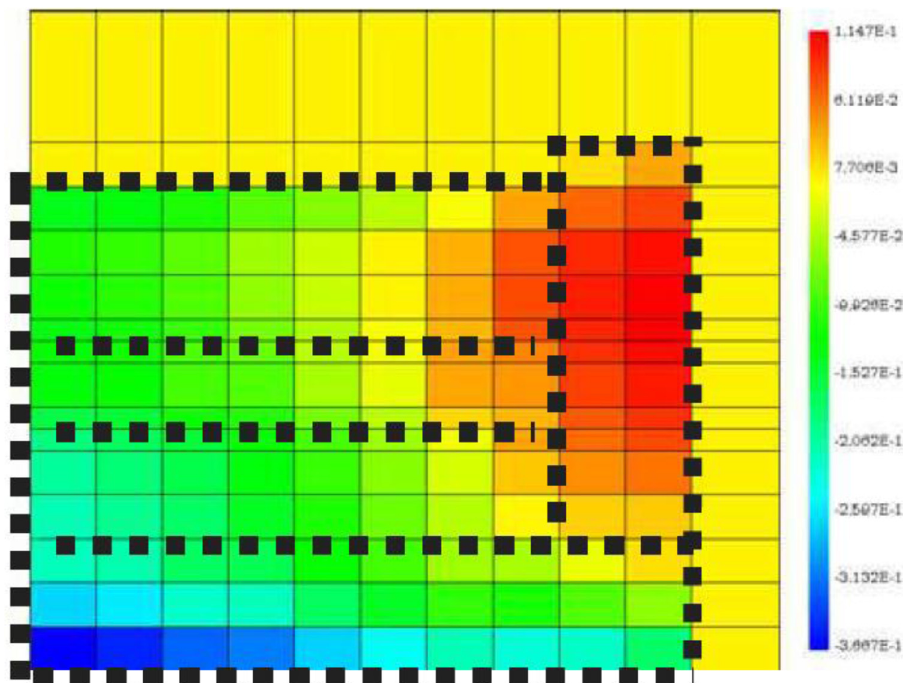
Fig. 5. ASTRID reactor (cid:1) Fissile +fertile partition into 132 regions (cid:1) Sensitivity of the fi ssion source distribution to the 16 O elastic cross-section.